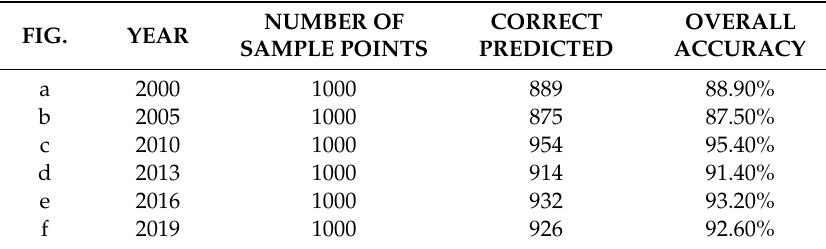
Table 4. Accuracy assessment and validation by method number 2.